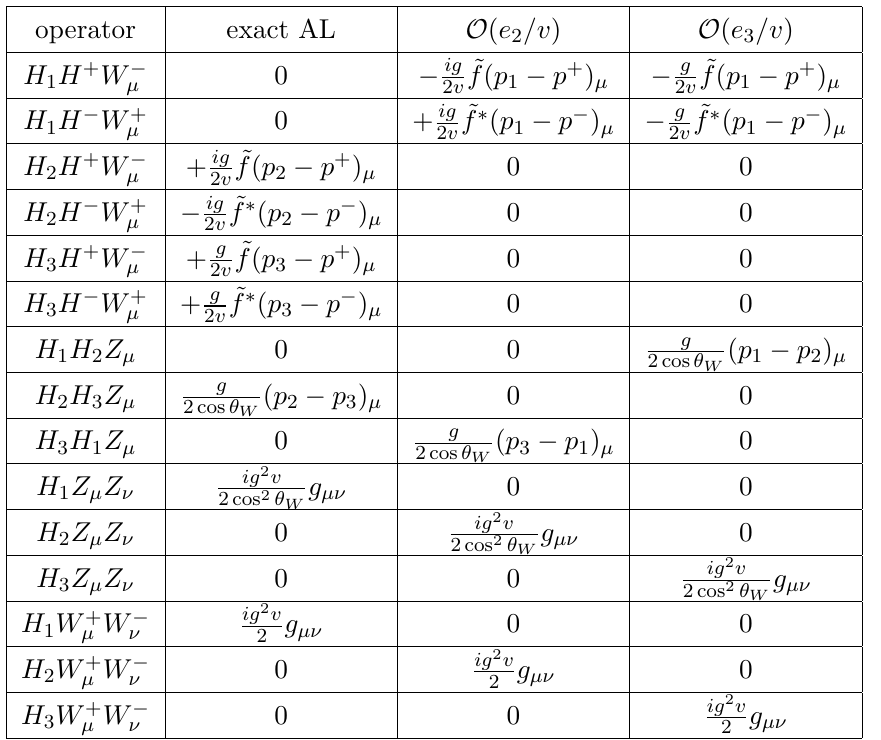
W (cid:0) operators ex- (cid:22) (cid:23)